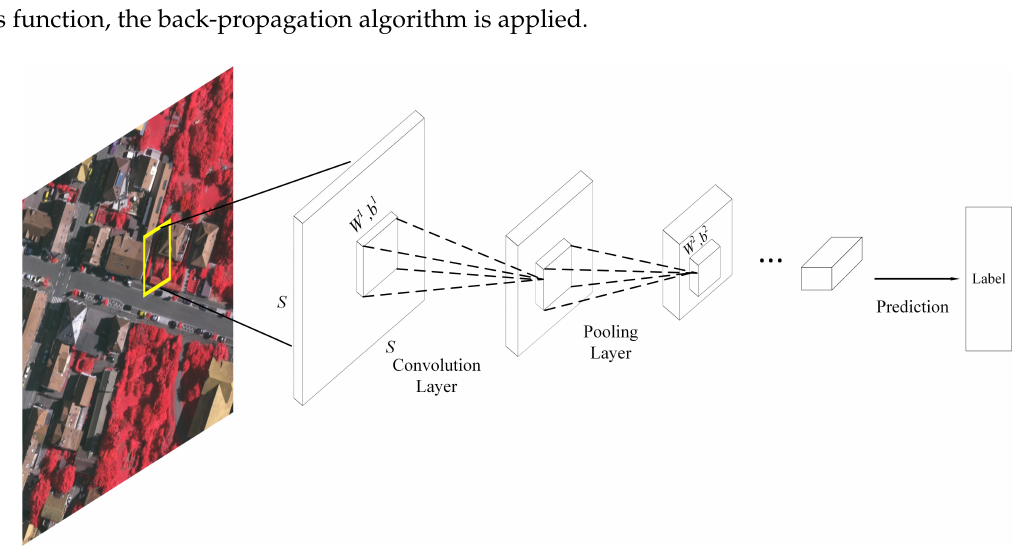
Figure 2. Semantic prediction using Convolutional neural